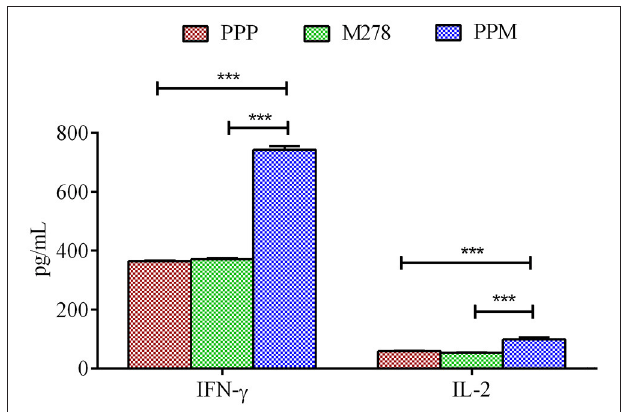
FIGURE 2 | Cytokines production by T-cells from immunized mice. Purified T-cells (1 × 10 6 ) and APCs (1 × 10 6 ) were stimulated with purified M278 (2.5 µ g/mL) and incubated for 120h at 37 ◦ C in a 5% CO 2 humidified atmosphere. Cell-free supernatants were collected by centrifugation and used to quantify cytokines (IFN- γ and IL-2) using specific ELISA. Each bar represents the mean ± standard deviation of triplicate samples. Significance was considered at *** P < 0.001. PPP (PLA-PEG-PBS immunized mice); M278 (bare M278-immunized mice); PPM (PLA-PEG-M278)-immunized